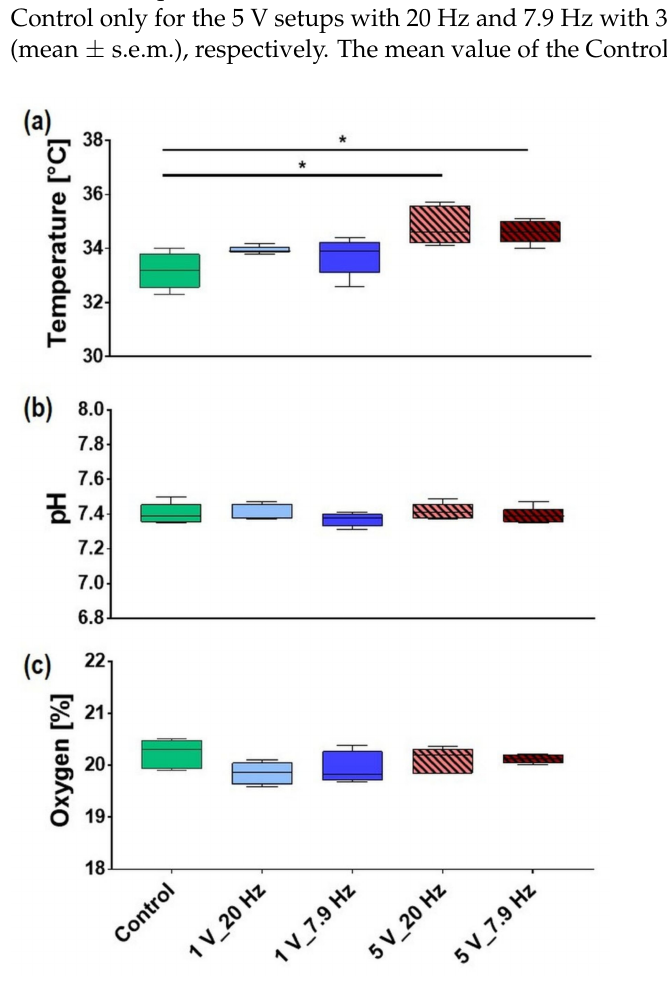
Figure 4. Properties of AC-stimulated liquids, i.e., the complete DMEM, after 10 min ES: ( a ) tempera- ture, ( b ) pH, and ( c ) oxygen content. Note that only the temperature changed for the 5 V settings. (median ± min/max, n = 5–6, one-way ANOVA posthoc Bonferroni, * p <